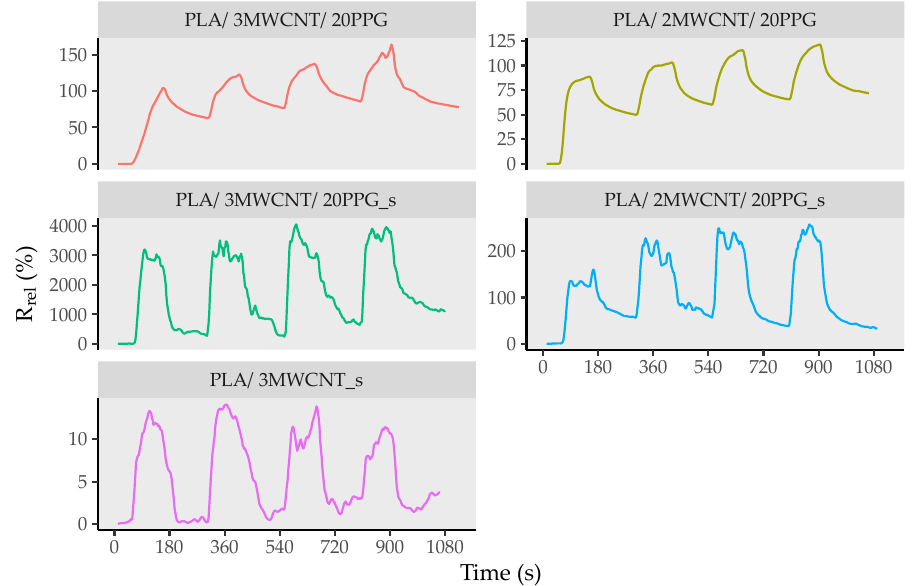
Figure 10. Typical electrical resistance response of PLA/MWCNT and PLA/MWCNT/PPG filaments to C 3 H 6 O vapor.